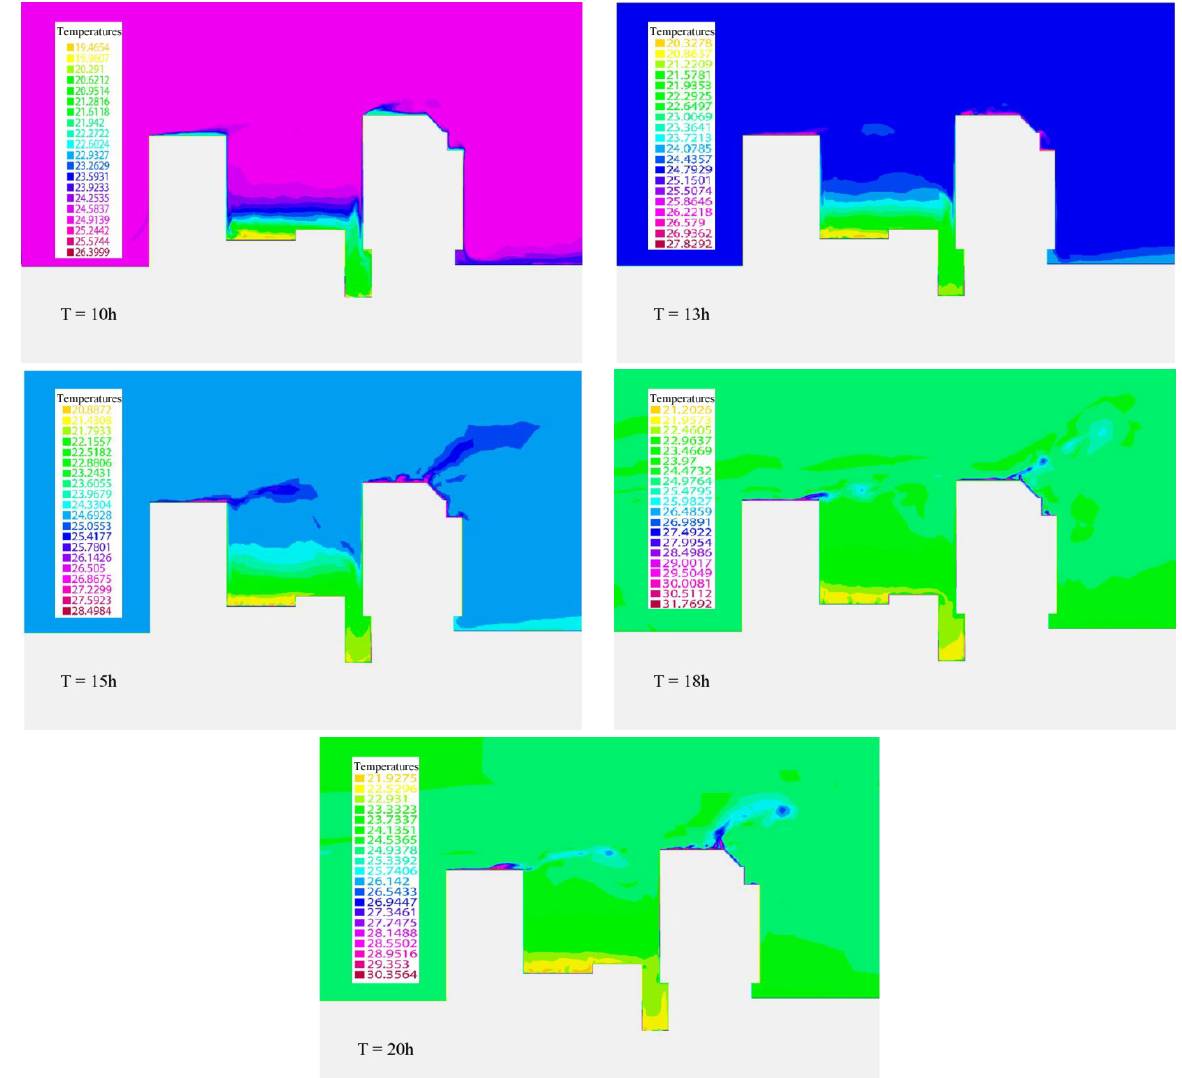
Figure 18. Test 2. Air temperatures. Forced extraction and wind. Solar radiation is imposed as boundary conditions. Temperature: °C; T: